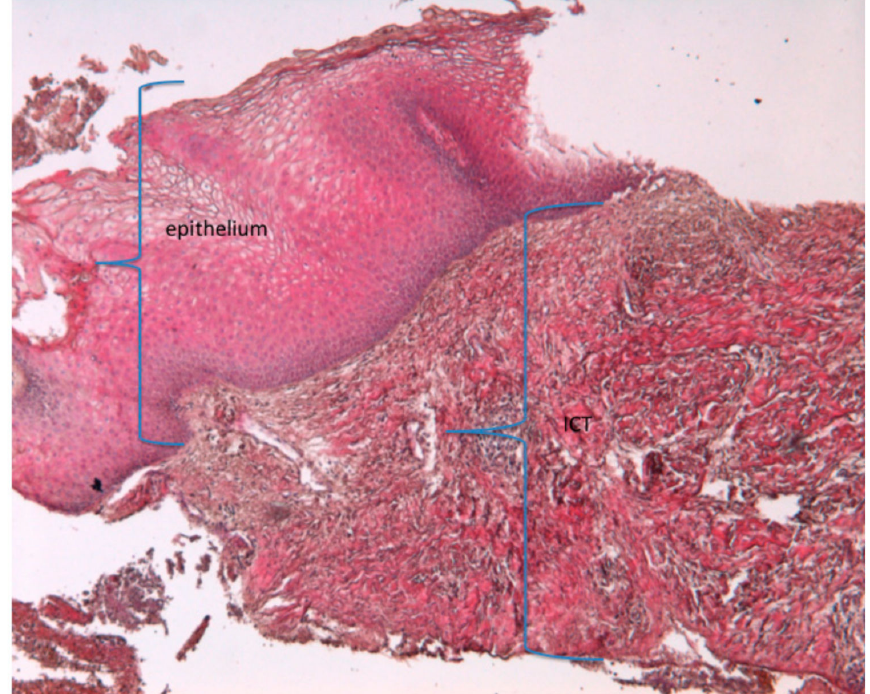
Figure 5. A histological staining with haematoxylin eosin. Presence of epithelium and ICT. (magnification 20 × ); ICT, inflamed connective